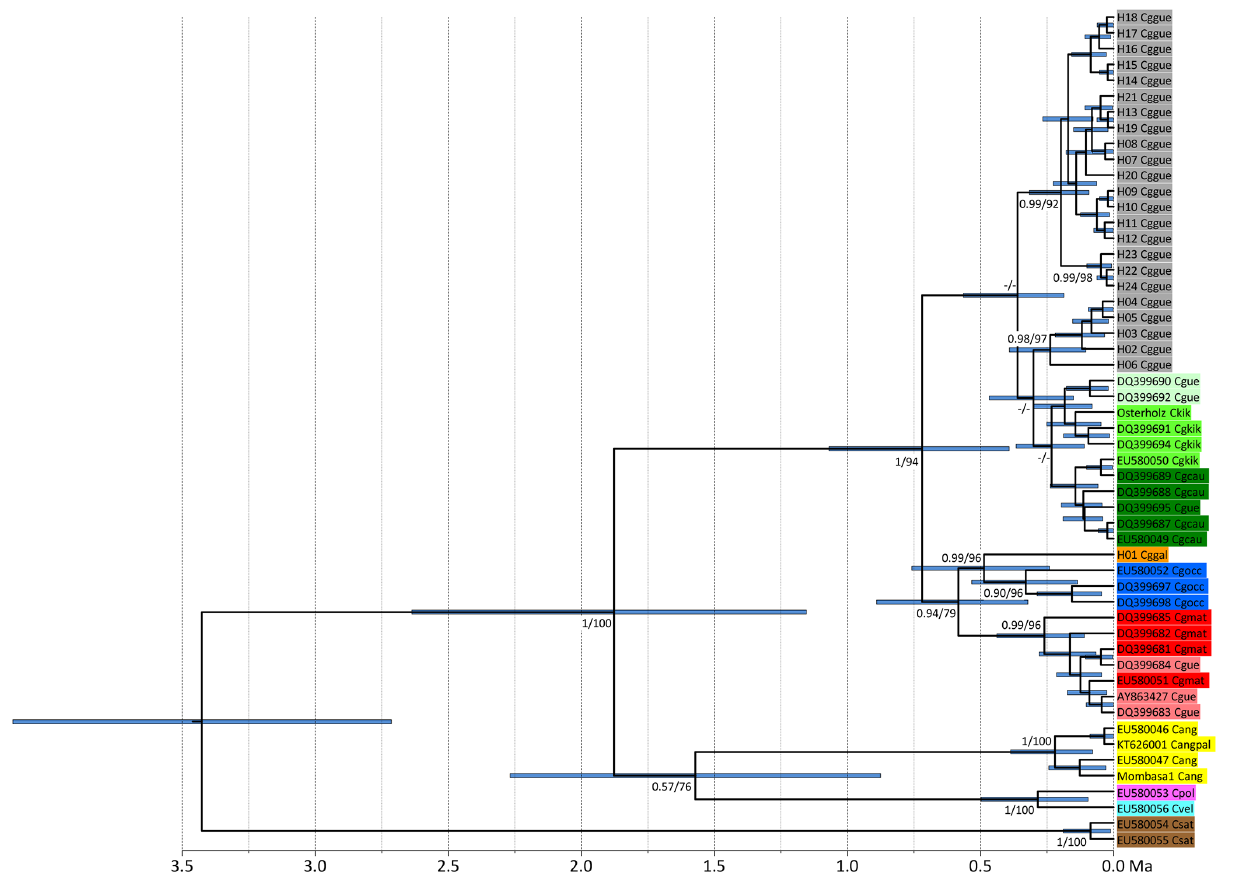
Figure 2. Ultrametric tree showing phylogenetic relationships and divergence times of Colobus mtDNA lineages (based on 790bp of NADH ). Tip labels refer to Colobus haplotypes (see Table S1). Csat: Colobus satanas ; Cvel: C. vellerosus ; Cpol: C. polykomos ; Cang: C. angolensis ; Cgocc: C. guereza occidentalis ; Cggal: C. g. gallarum ; Cgmat: C. g. matschiei ; Cggue: C. g. guereza ; Cgkik: C. g. kikuyuensis ; Cgcau: C. g. caudatus ; Cgue: C. guereza ssp. Node labels refer to ML BS and Bayesian PP support values. The timescale below the tree indicates million years